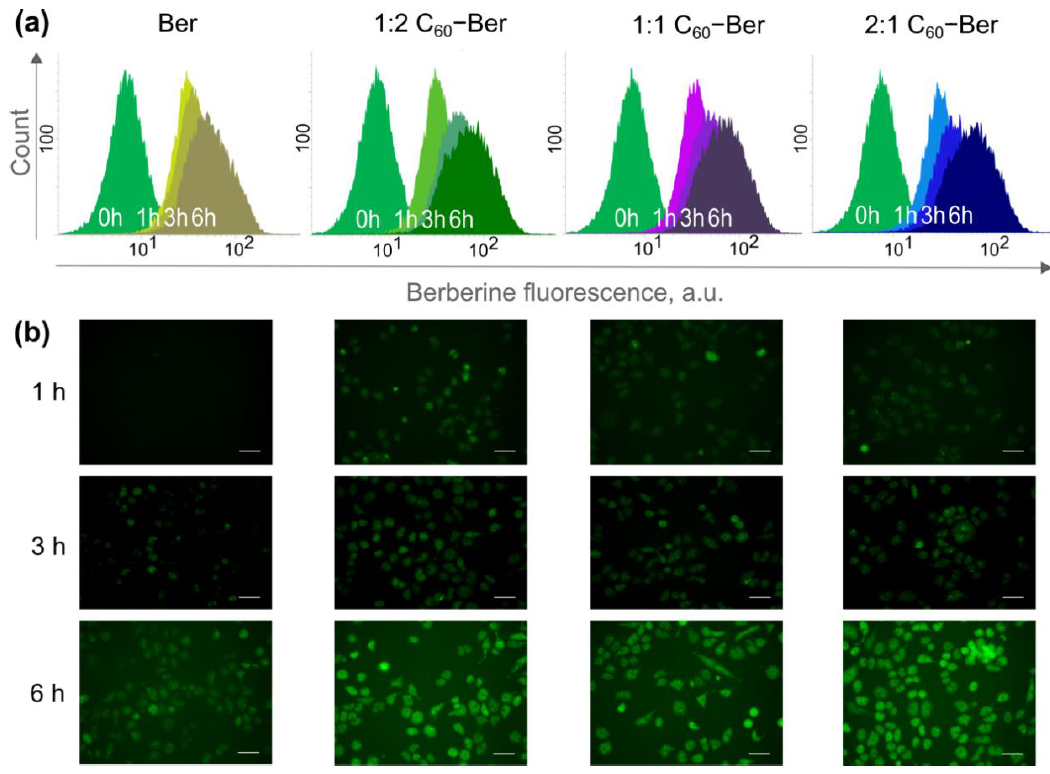
Figure 8. Intracellular accumulation of the free 10 µM Berberine and C 60 –Ber nanocomplexes in a Ber-equivalent concentration: flow cytometry ( a ) and fluorescent microscopy ( b ) of CCRF-CEM cells incubated with Ber and C 60 -Ber nanocomplexes at the molar ratios 1:2, 1:1, and 2:1; scale bar: 20 µm. Table 4. Mean fluorescence intensity (FI) of the intracellular accumulated Ber measured with flow cytometry. FI, a.u.